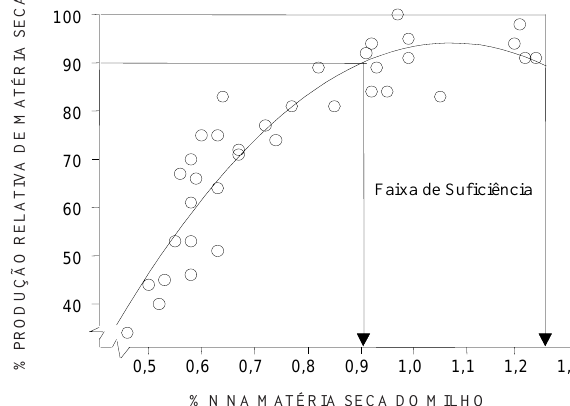
Figura 1. Relação entre a concentração de N e a produção relativa de matéria seca da parte aérea do milho na floração, durante o ano de